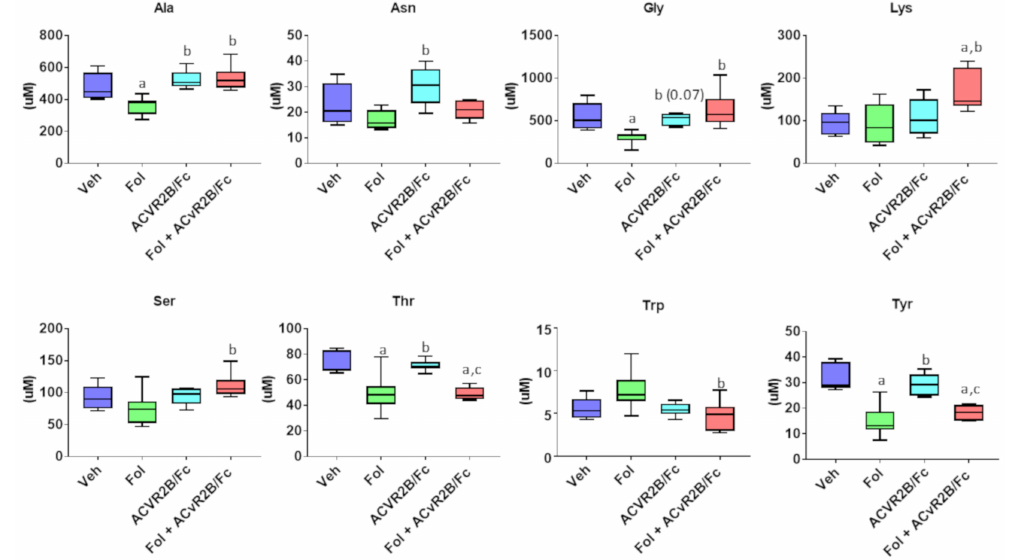
Figure 10. Amino acids from skeletal muscle extracts showing at least one significant inter-group di ff erence. Significance di ff erences include p -values < 0.05 for a vs. Veh, b vs. Folfiri, c vs. ACVR2B /